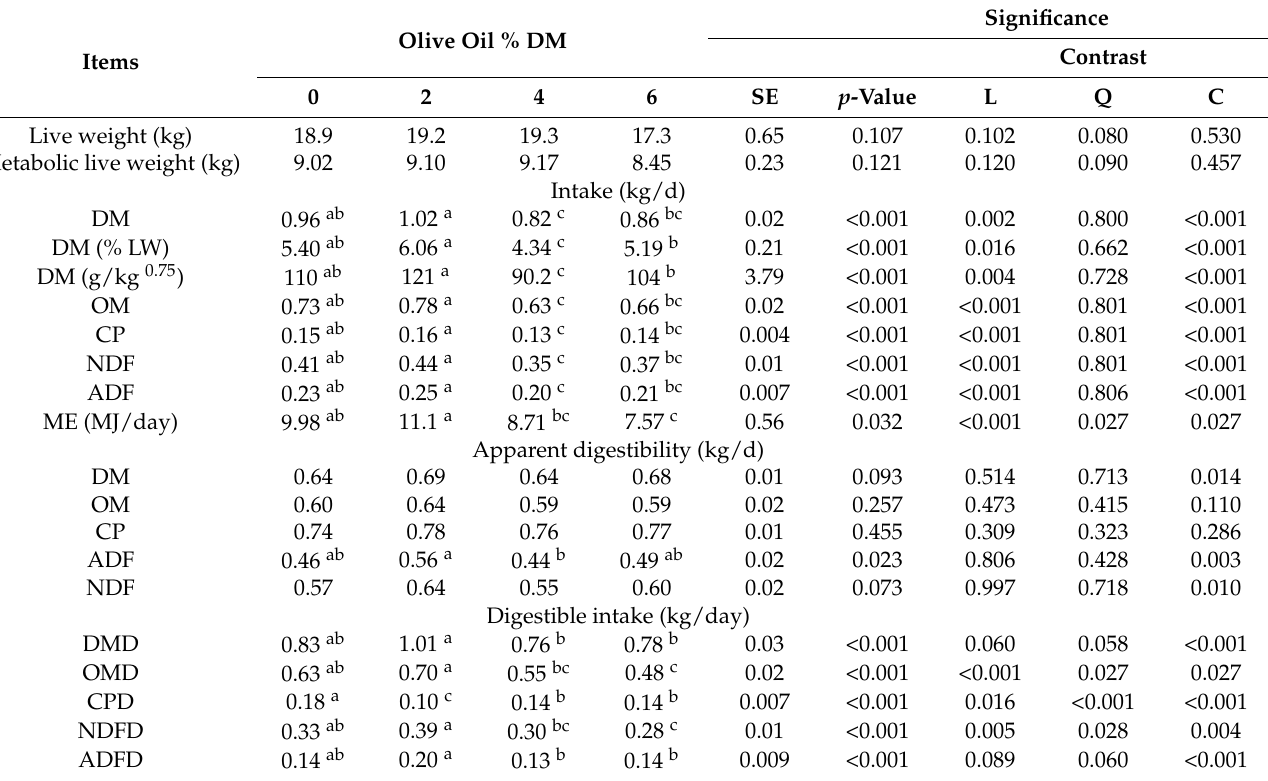
Table 3. Intake and apparent digestibility of lambs fed with different levels of olive oil.